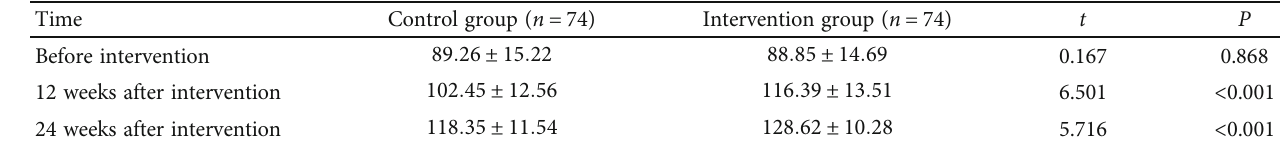
Table 3: Score of ESCA between the two groups (point, (cid:1) x ± s ).